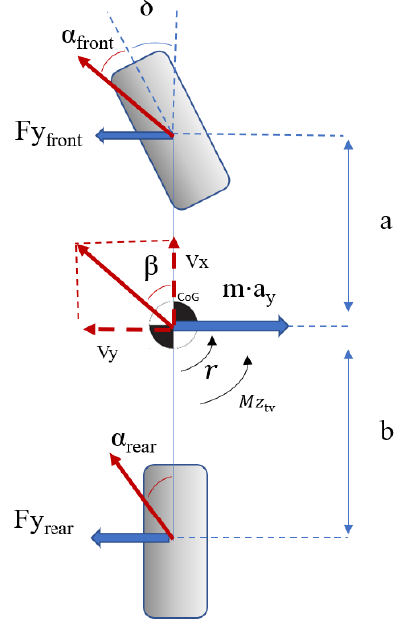
Figure 1. Linearized bicycle model.